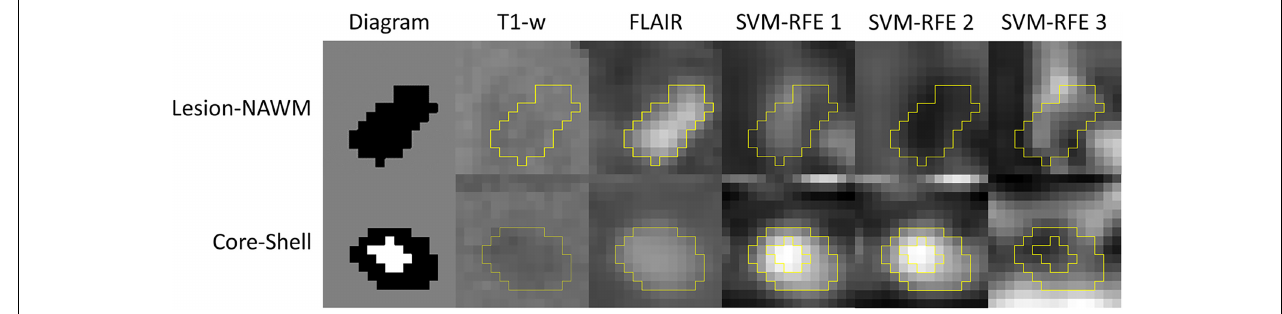
FIGURE 4 | Example lesion regions and top diffusion metrics identified in the tissue separation processes. Shown are diagrams for a whole lesion (black, top) and a core-shell lesion (white and black, bottom) used for the lesion versus NAWM and core versus shell classifications, as well as corresponding appearances in the T1-weighted and FLAIR MRI (columns 1–3). The other columns (4–6) demonstrate the top three diffusion features selected by the recursive feature elimination algorithm (SVM-RFE) in respective classification tasks, which are orientation distribution function energy, fractional anisotropy, and orientation dispersion index (top); and mean diffusivity, radial diffusivity, and fractional anisotropy (bottom).